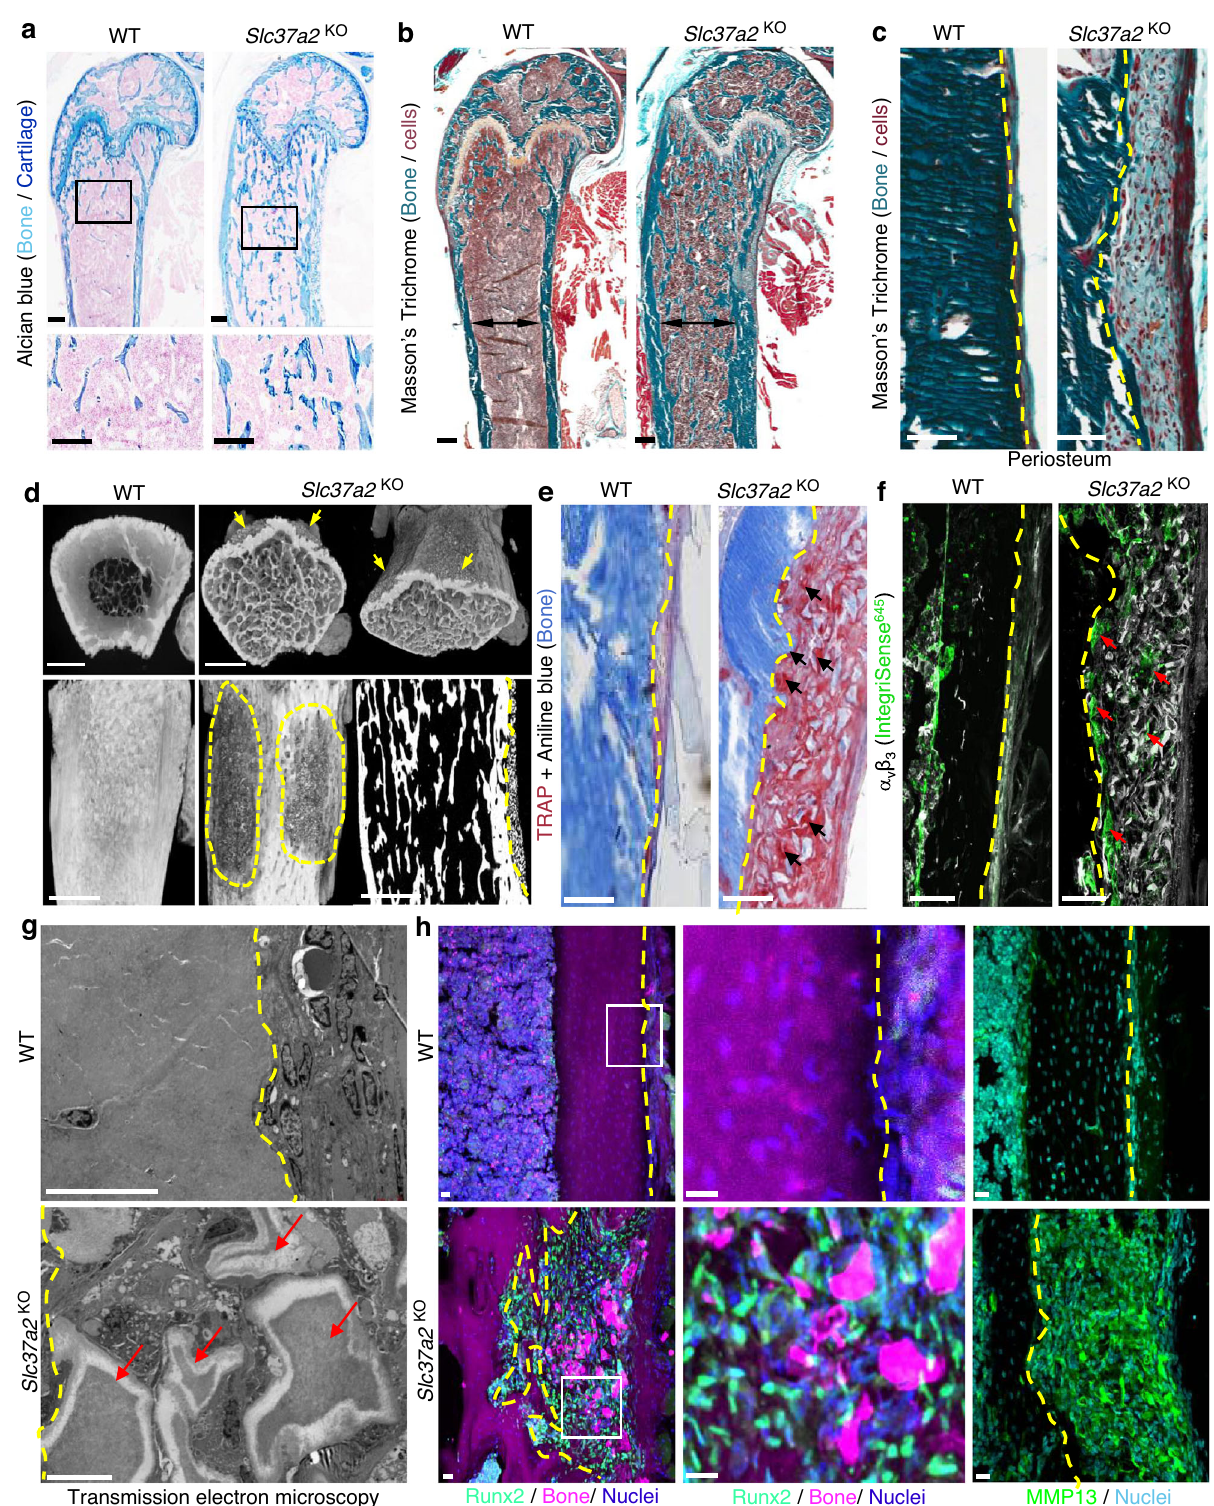
e and f HistologicalevaluationofTRAP + ( e , n =3)and α v β 3 + ( f , n =3)cellsalongthe periosteal surface of 12-week-old femurs from female WT and Slc37a2 KO mice. Dashed lines denote the periosteal bone surface, arrows indicate TRAP + or α v β 3 + cells. Bars, 1mm. g Transmission electron microscopic evaluationofthe periosteal layer of femurs from WT and Slc37a2 KO ( n =2). Dashed yellow lines indicate the periosteal bone surface. Red arrows depict demineralized bone/cartilaginous fragments. Bars, 10 µ m. h Representative images of cryosections depicting the periosteal surface along the femurs of 12-week-old female WT and Slc37a2 KO mice immunostained for Runx2 or MMP13 ( n =4). Bars, 20 µ m.